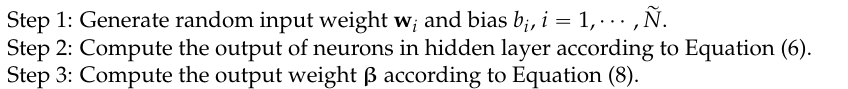
Table 1. Flow of the ELM algorithm.